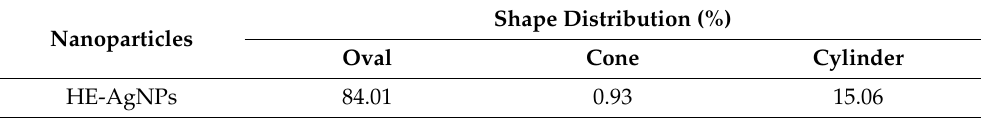
Figure 3. High-resolution transmission electron microscopy images showing the morphology of ( A , C ) HE-AgNPs and ( B , D ) HP-AgNPs. ( E , F ) are histograms displaying the particle size distribution of HE-AgNPs and HP-AgNPs, respectively. Table 1. HE-AgNPs consist of various shapes with spheres dominating.